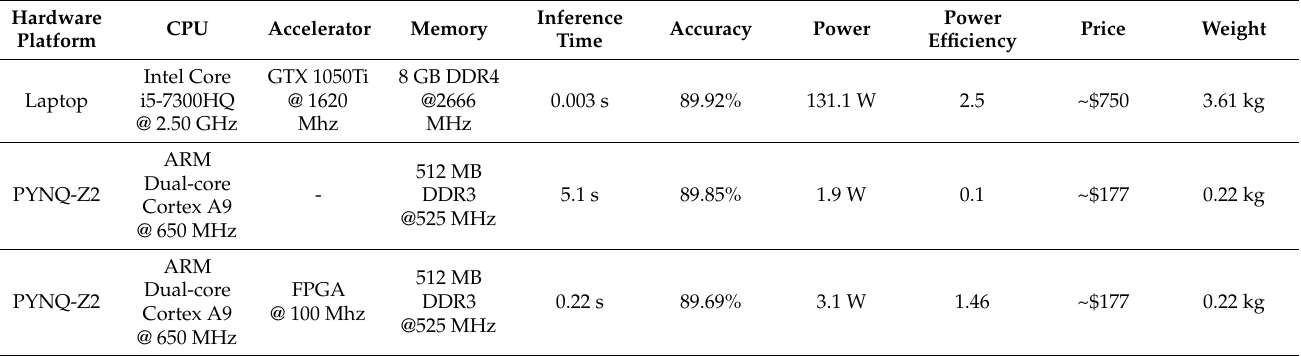
Table 5. The comparative performance of eye state